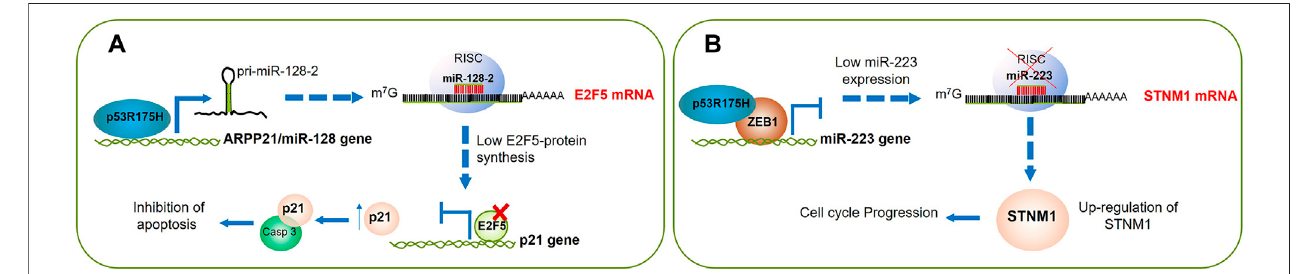
FIGURE 4 | The cell cycle progression and inhibition of apoptosis can be triggered by p53R175H. (A) Mutant p53R175H induces miR-128-2 expression whose directtargetisE2F5mRNA.DownregulationofE2F5blocksitsrepressiveactivityonp21transcription,thenp21proteinisaccumulatedinthecytoplasm,whereitexerts ananti-apoptoticeffectbybindingtopro-caspase-3. (B) ZEB1bindstomiR-223genepromoterandalongsidep53R175HbothinhibitmiR-223transcription,thisallows increasing synthesis of STNM1 that is involved in chemoresistance and cell cycle